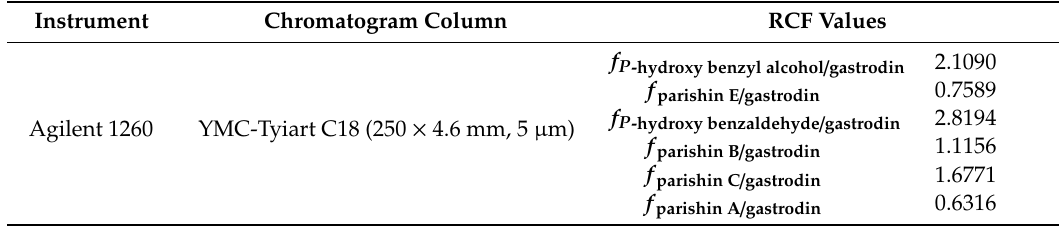
Table 5. Relative correction factor (RCF) values of six components of the G. elata